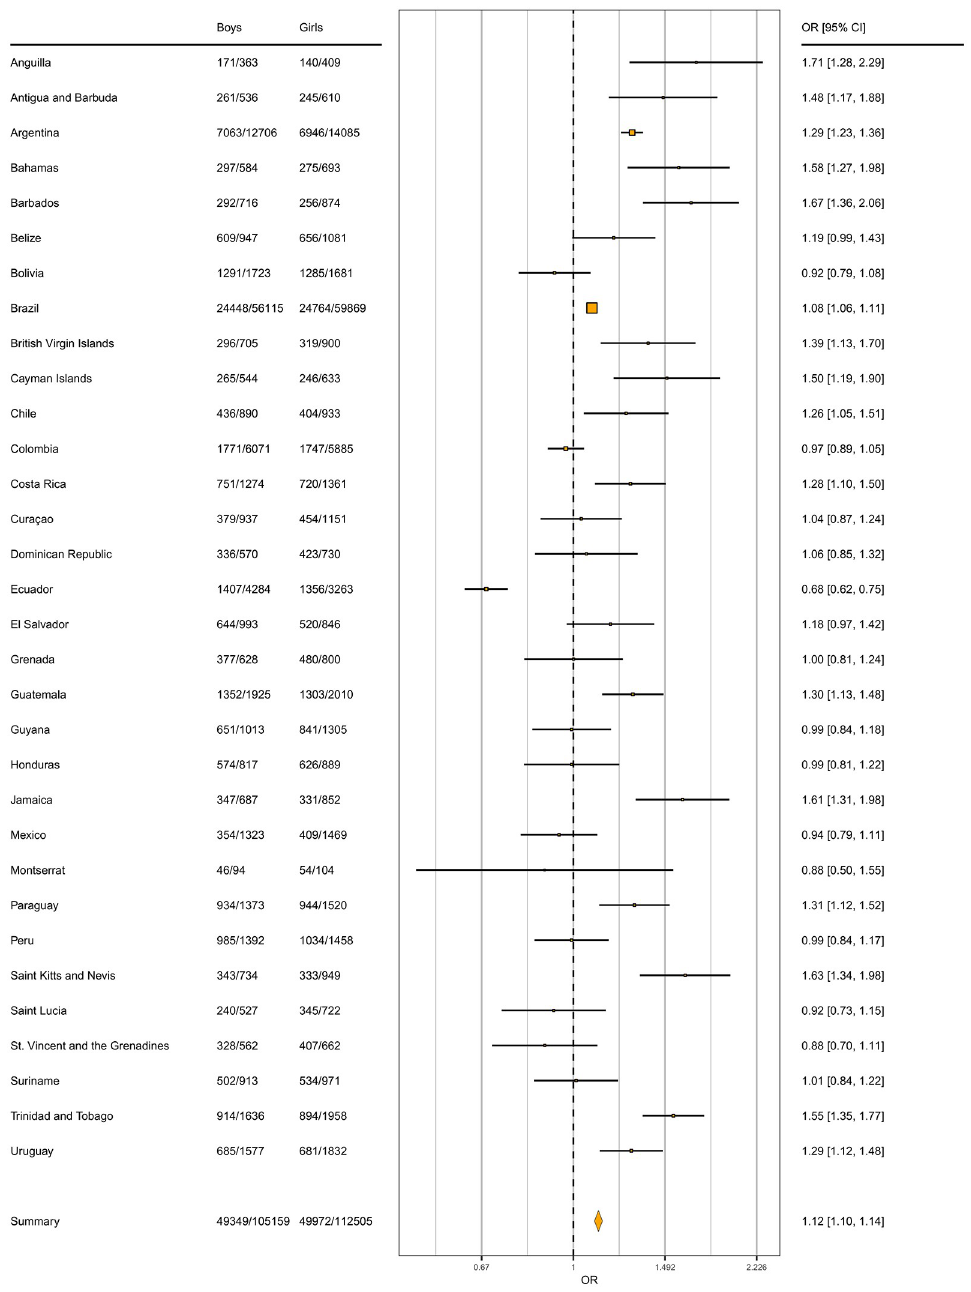
Fig 5. Forest plot showing the odds ratio of meeting the < 3 hours recreational SB cut-point by gender in children and adolescents from Latin-America, by country. Reference = girl.